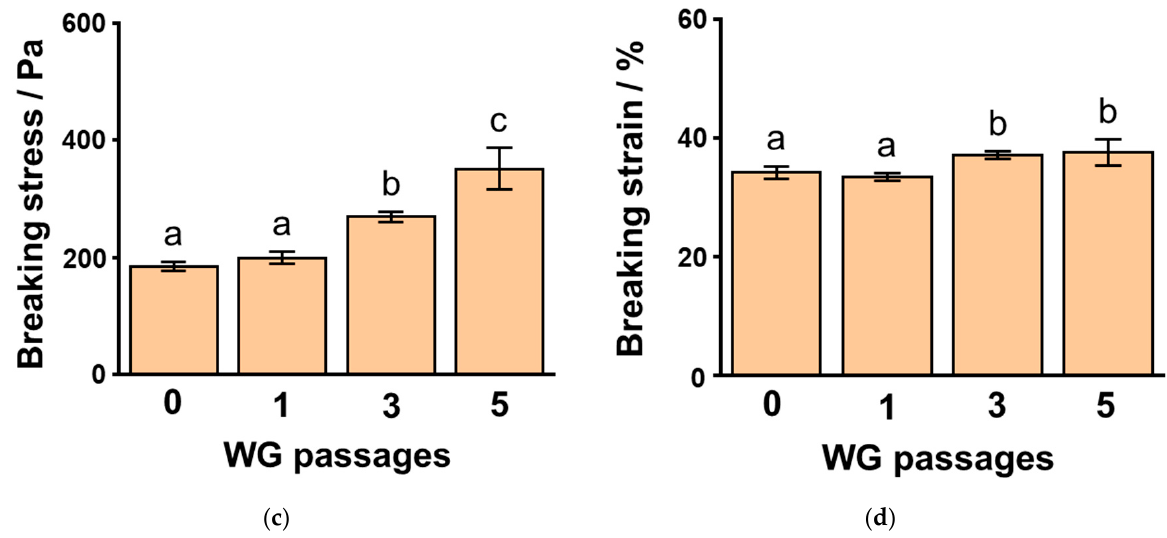
Figure 3. The breaking stress ( a , c ) and strain ( b , d ) of 6% soybean protein isolate (SPI) gels to which 1% wet-type grinder (WG)-treated okara was added after different passages at 1.0% ( a , b ) and 1.5% ( c , d ) sodium chloride concentration. Differ- ent letters indicate significant differences ( p < 0.01).